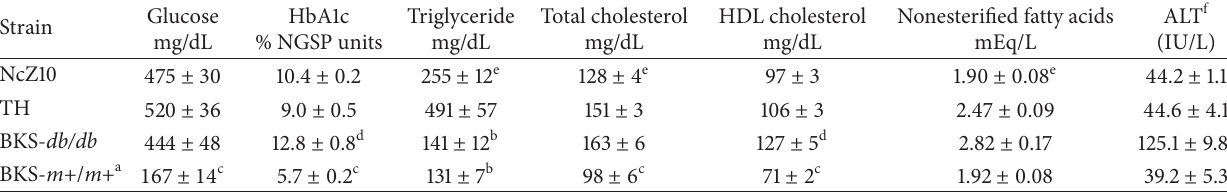
a m +/ m + from the cross with the db gene in repulsion with the misty ( m ) gene. b db/db and lean control significantly lower ( 𝑃 ≤ 0.05 ) than TH and NcZ10. c Lean control significantly lower ( 𝑃 ≤ 0.05 ) than all 3 diabetic stocks. d db/db significantly higher ( 𝑃 ≤ 0.05 ) than TH and NcZ10. e NcZ10 significantly lower ( 𝑃 ≤ 0.05 ) than TH and db/db